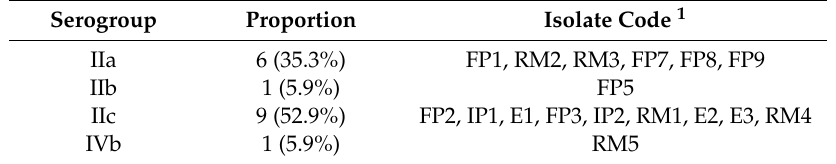
Table 2. Description of the obtained serogroups among L. monocytogenes confirmed isolates ( n = 17).